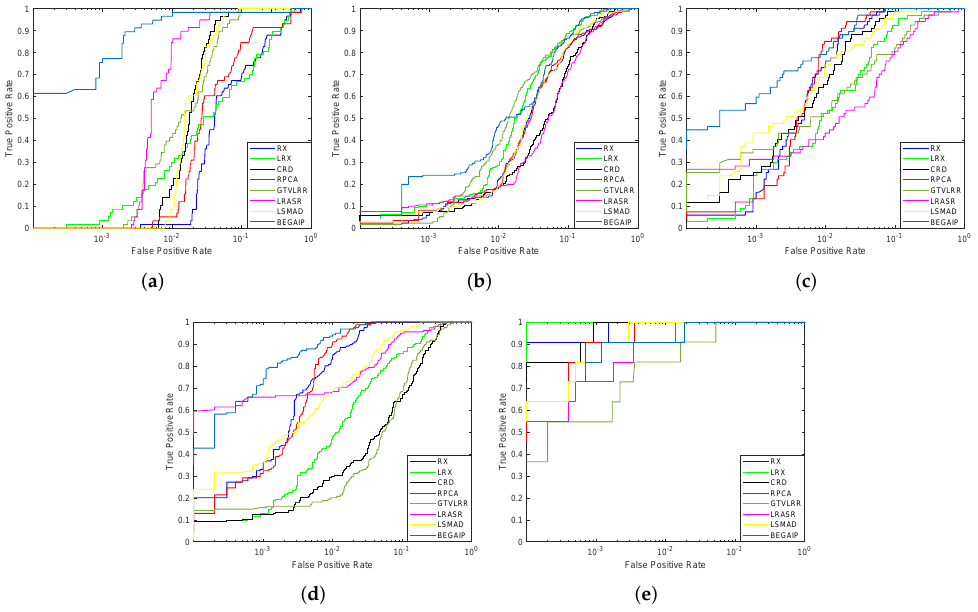
Figure 11. ROC curves of all the algorithms on four data sets. ( a ) San Diego data set. ( b ) Los Angeles data set. ( c ) TC data set-I. ( d ) TC data set-II. ( e ) Bay Champagne data